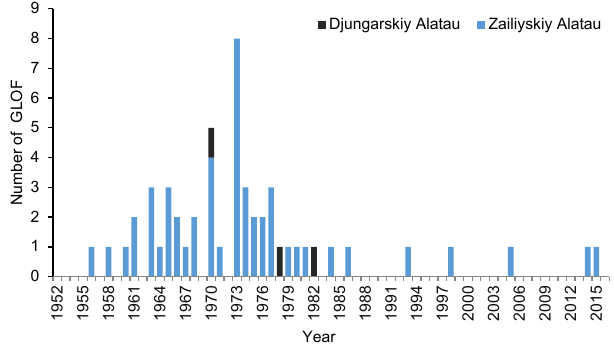
Figure 12. GLOF events attributed to an increase in air tempera- ture and melt (as opposed to precipitation), which resulted in the recorded damage to housing and infrastructure in the Zailiiskiy and Djungarskiy Alatau. The data before 1985 are from Popov (1986); data for the later years were provided by